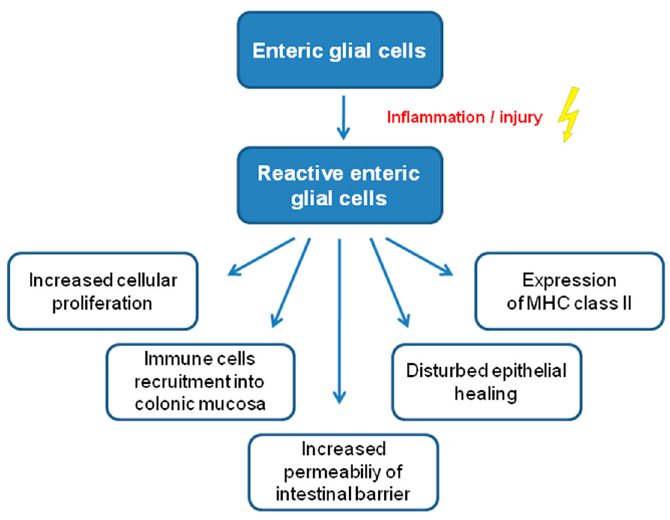
Figure 2. Summary of the properties of reactive enteric glial cells. Abbreviations: MHC, major histocompatibility complex.